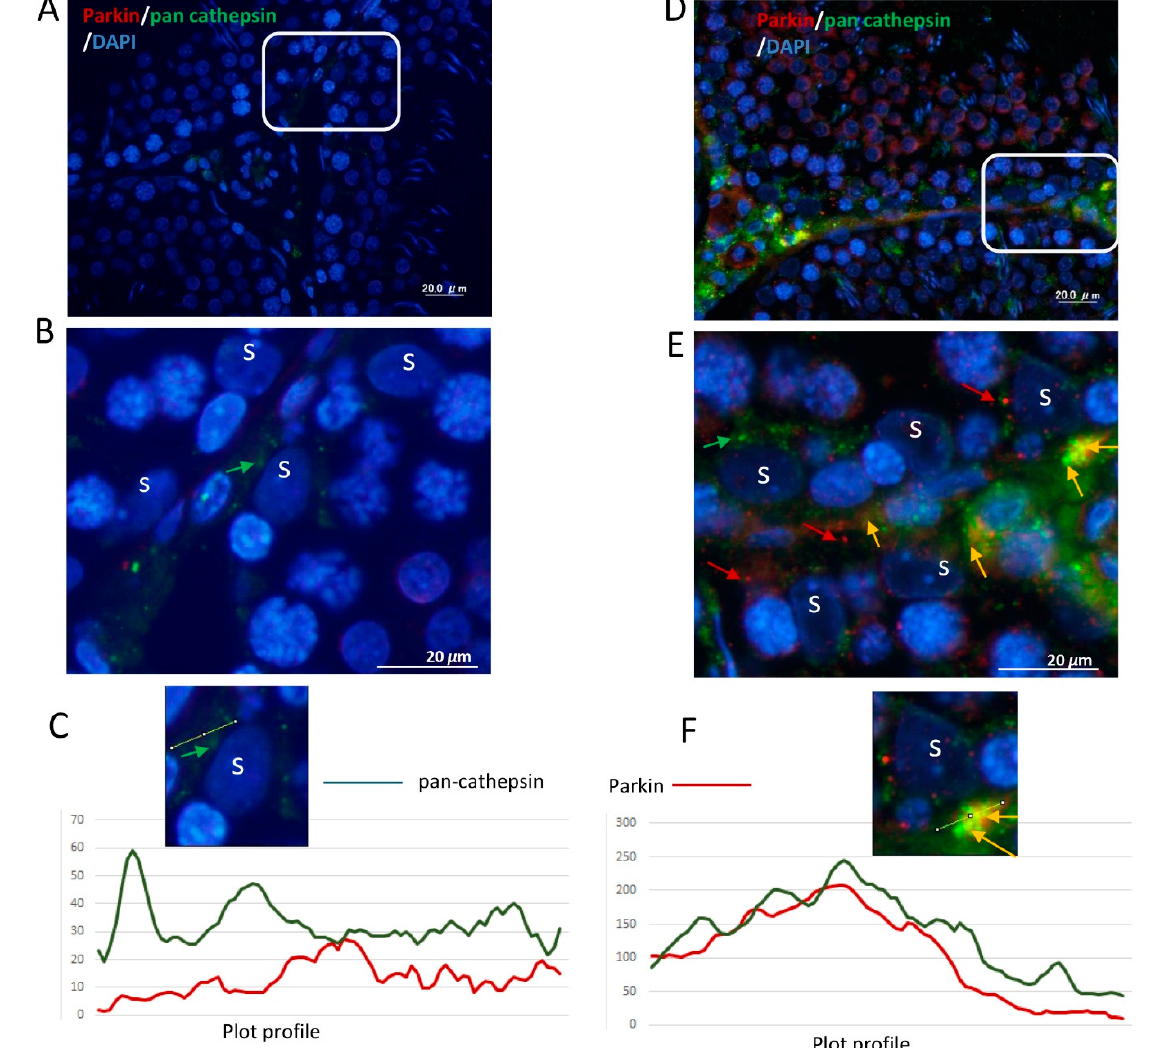
Figure 7. Elevated expression and colocalization of Parkin with pan cathepsin in ETRs SCs. (control, A – C ), (ETRs, D – F ). The framed areas in ( A ) and ( D ) are magnified in ( B) and ( E) , respectively. Note the enhanced expression and colocalization of Parkin (red, red arrows) and pan-cathepsin (green, green arrows) upon merging (orange-yellow, orange arrows) in ETR SCs ( D , E ) compared to control ( A , B ). S: SC nucleus. DAPI (blue) was used for nuclear counterstaining. ( C , F ) Plot profiles demonstrating the colocalization of Parkin and pan-cathepsin defined as overlapped red and green peak at the lines positioned in images (cropped from panels B , E ) just above the histograms. 3.4. Enhanced Mitophagy in SCs of ETRs is Associated with TFEB Nuclear Translocation and Induction of